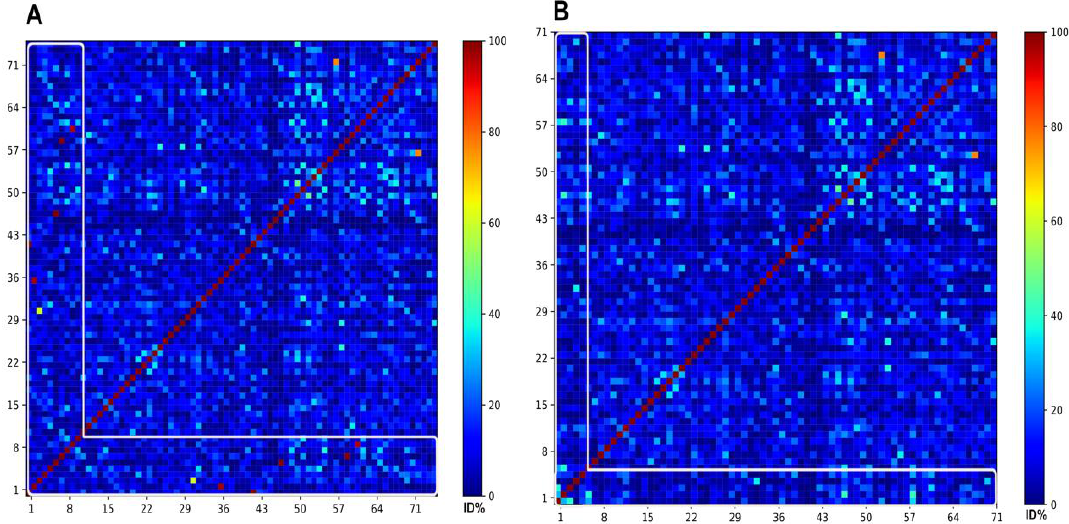
Figure 10. Heat maps corresponding to the pairwise identities from the comparison of the 14 ABFPs representing the mechanisms of action classes against the 66 representatives of the antibiofilm chem- ical space. ( A ) the 9 ABFPs that could be mapped on the representative HSPN at AF similarity > 0.60 occupy the from 1 to 9 position in the heatmap. ( B ) the 5 that did not map at AF > 0.60 were placed from 1 to 5 position. The target zone of the heat maps is framed by a white line. All- vs -all global alignments and heat maps visualization were conducted using the SeqDivA software reported in [71].